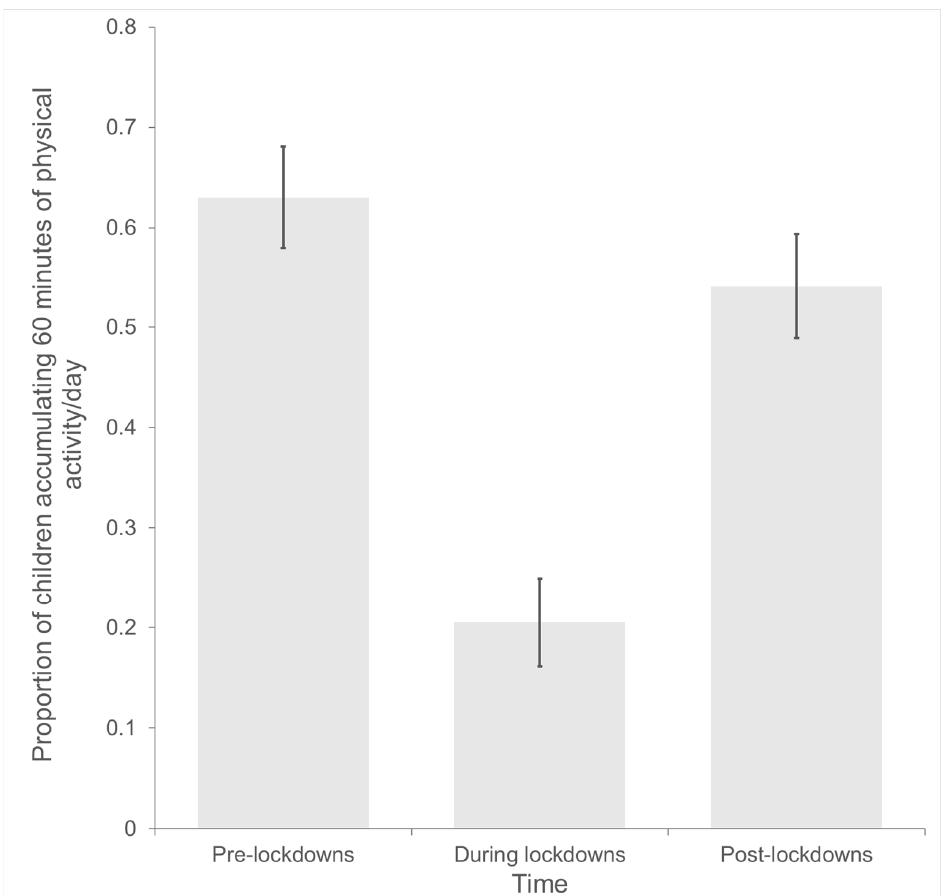
Figure 2. Proportion of children attaining 60 minutes of physical activity, as reported by parents, pre-lockdown, during lockdowns, and